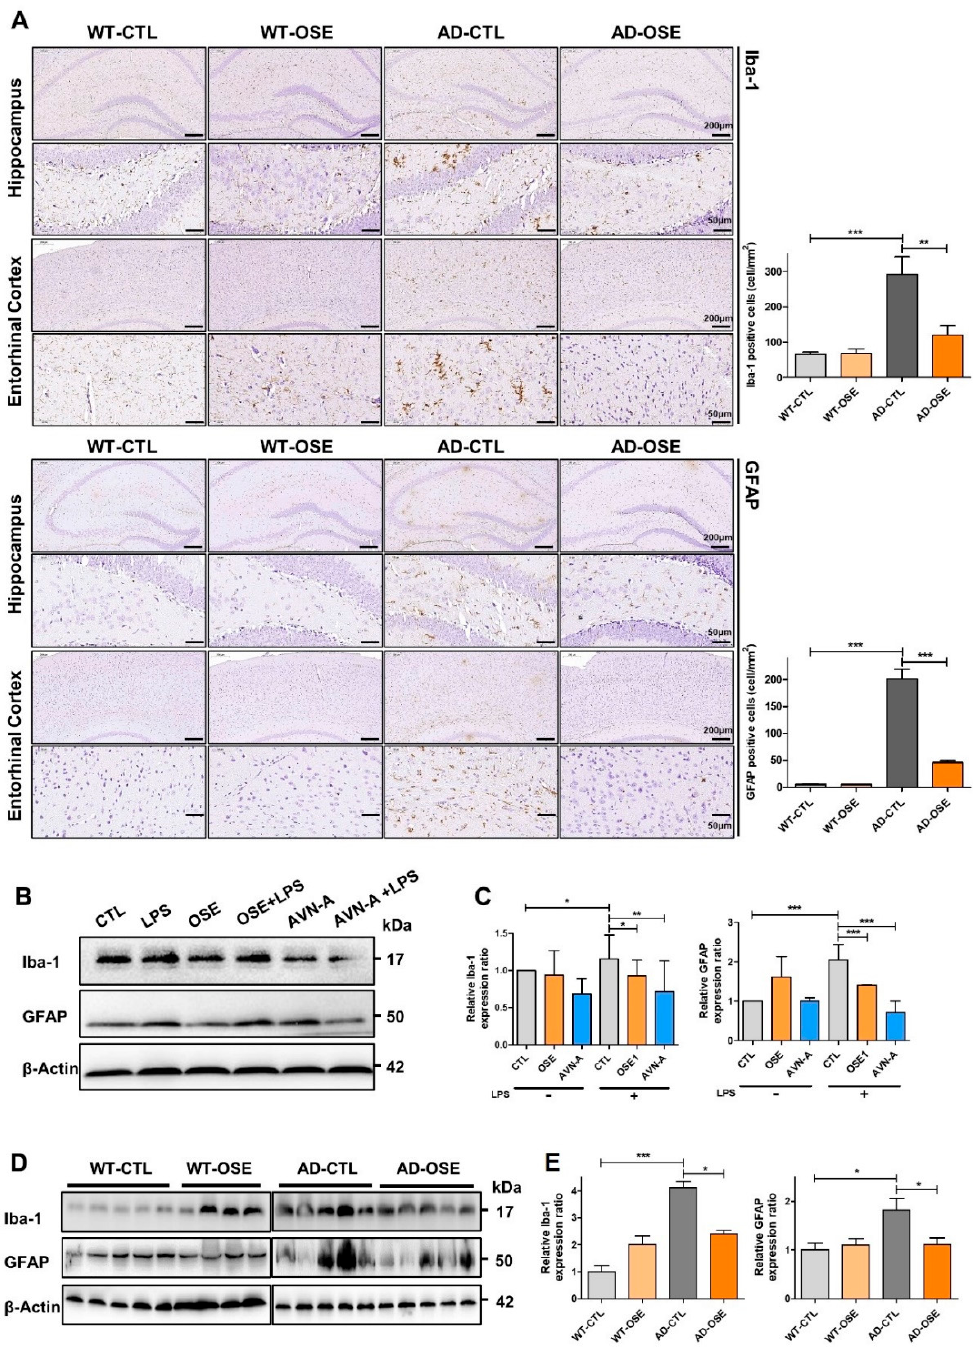
Figure 4. Reduced reactive astrocytes and active microglia. ( A ) Immunohistochemistrical staining of GFAP and Iba1 within the brain sections’ hippocampus and entorhinal cortex in Tg-5xFAD AD and WT mice after exposure to OSE. ( B , D ) GFAP and Iba1 Western blotting in cell line and Tg-5xFAD AD mice after exposure to OSE and AVN-A. Actin is being utilized as the loading control. ( C , E ) Validation of differentially expressed proteins by Western-blot analysis. * p < 0.05, ** p < 0.01, *** p < 0.001.